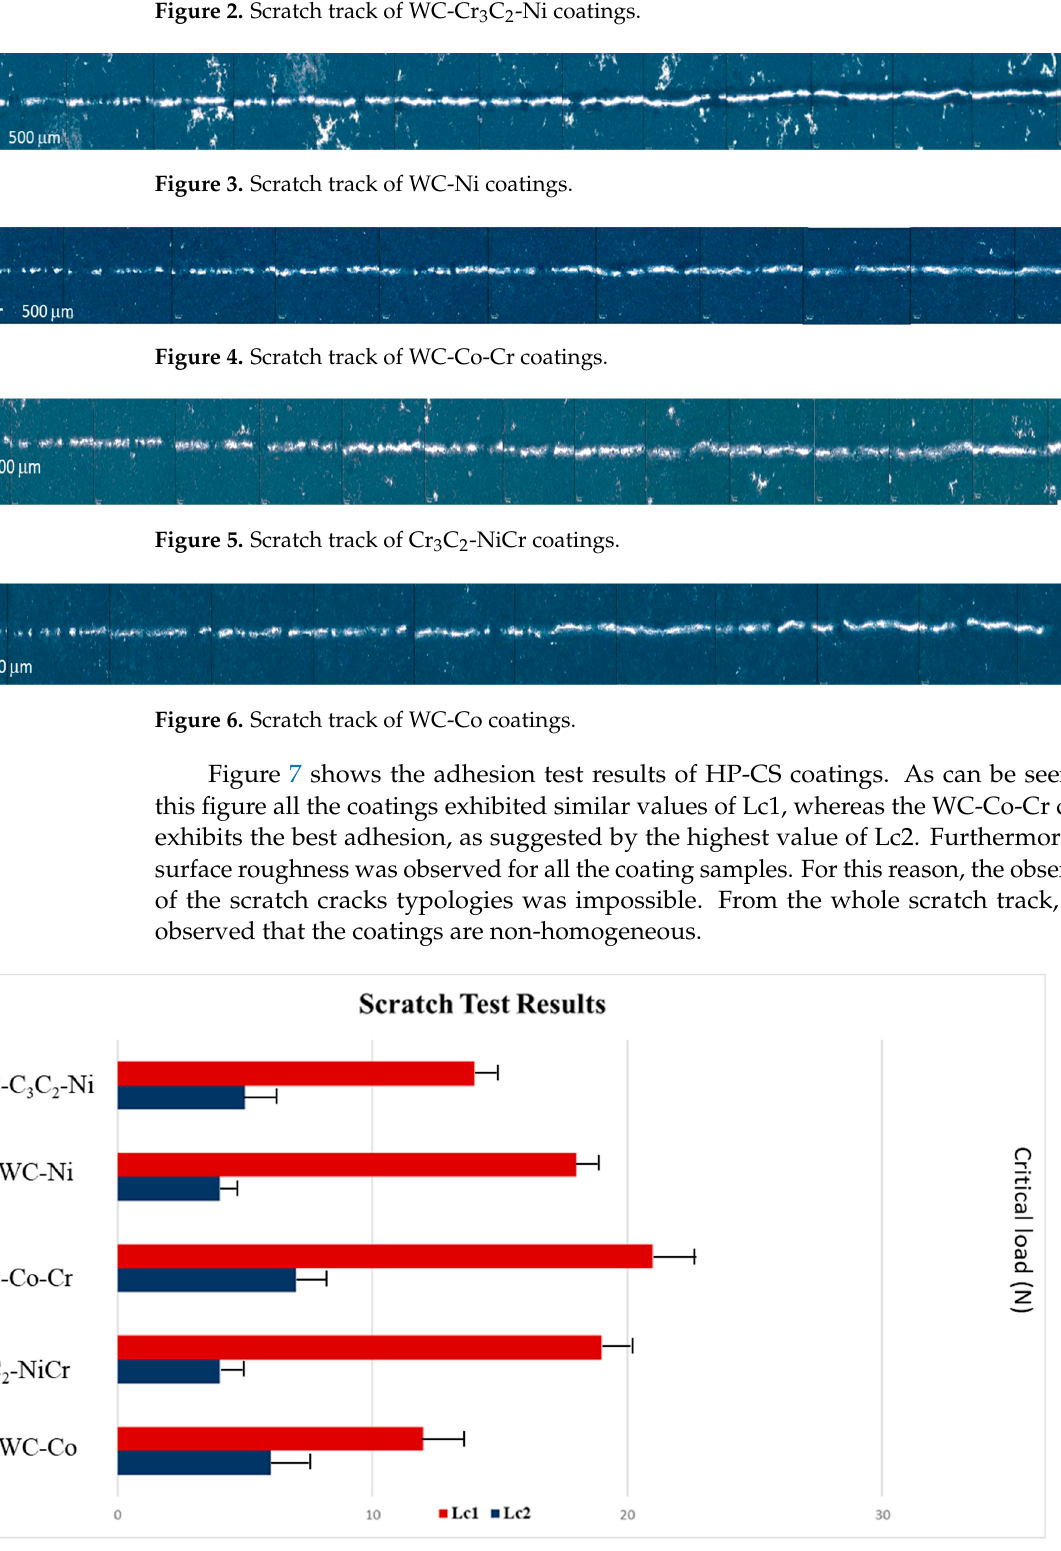
Figure 7. Scratch test results and their standard deviation.